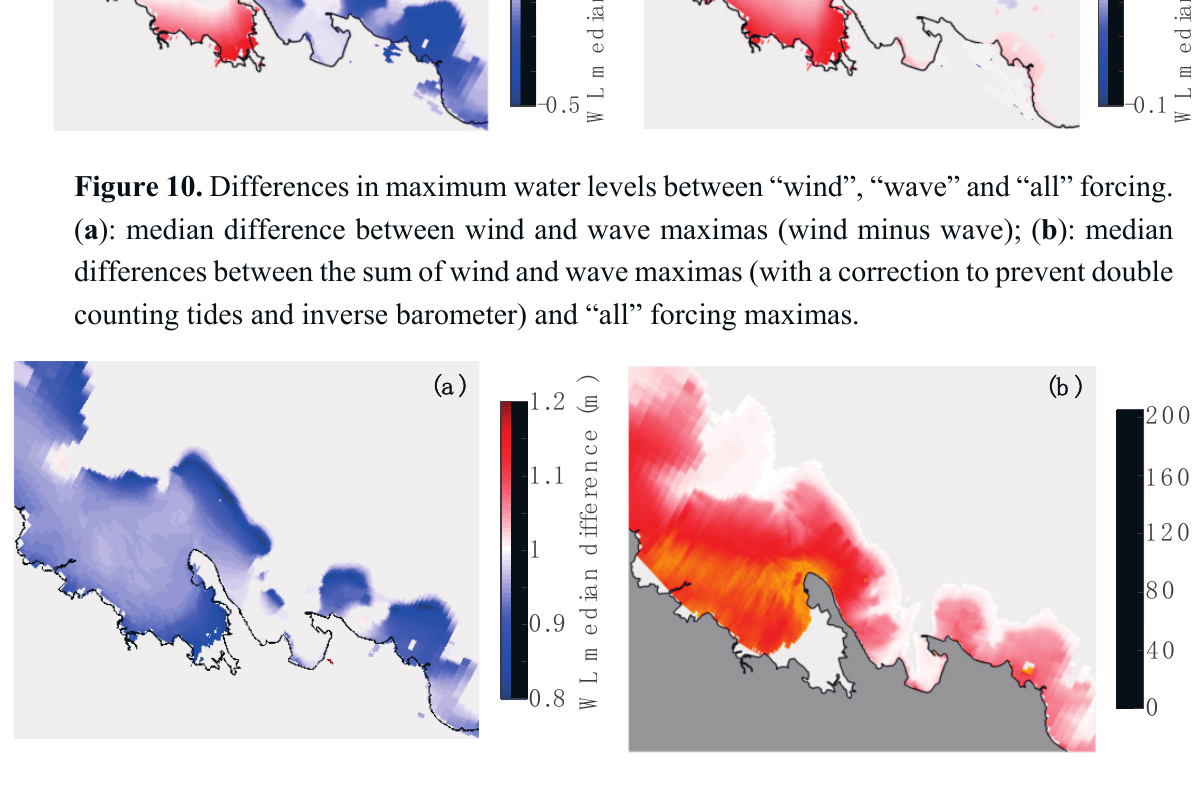
Figure 11. ( a ) Median differences between maximum water levels (WL) of the “SLR” and “baseline” ensemble members (“all” forcing); ( b ) median percent difference between maximum significant wave height ( H s ) of the “SLR” and “baseline” ensemble members (“all” forcing). In ( b ) areas with median H s less than 0.05 m or absolute differences of less than 5% are not